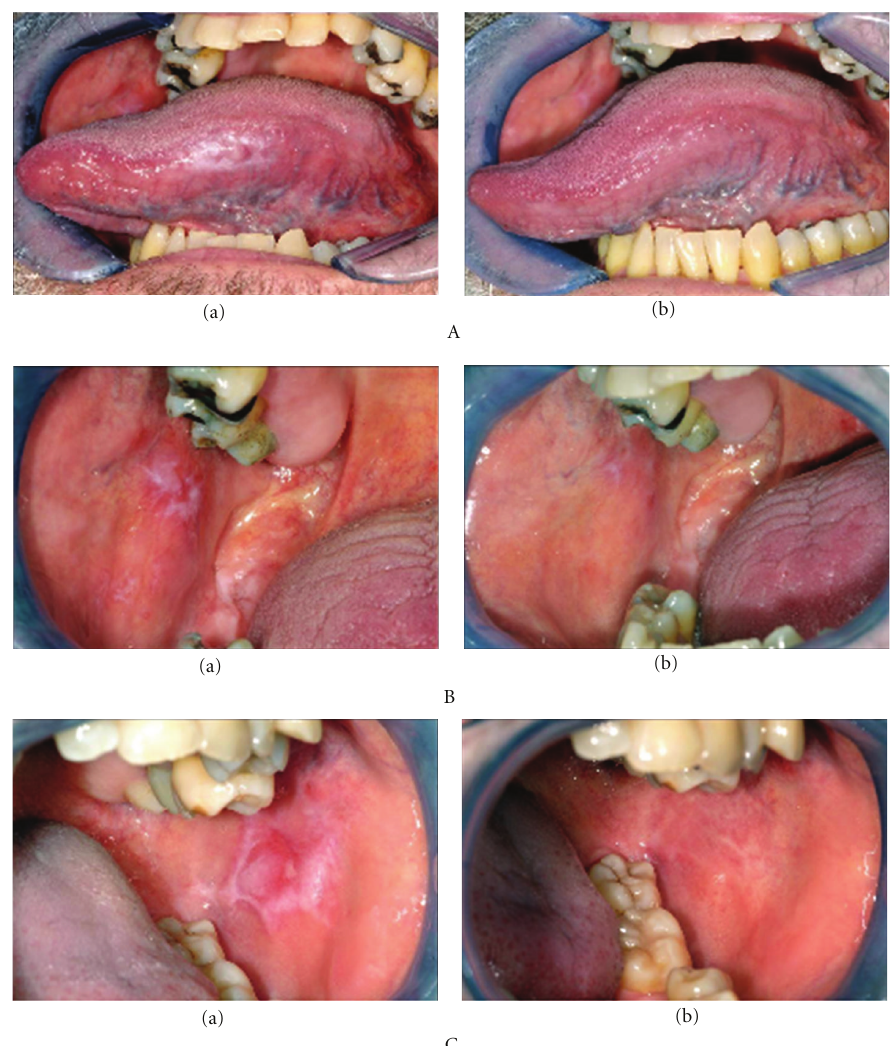
Figure 4: Illustrations showing resolution or partial resolution of lichenoid lesions following removal of amalgam restorations. All were in close contact with an amalgam filling. Panel A at the time of detection and Panel B after removal of the o ff ending amalgam